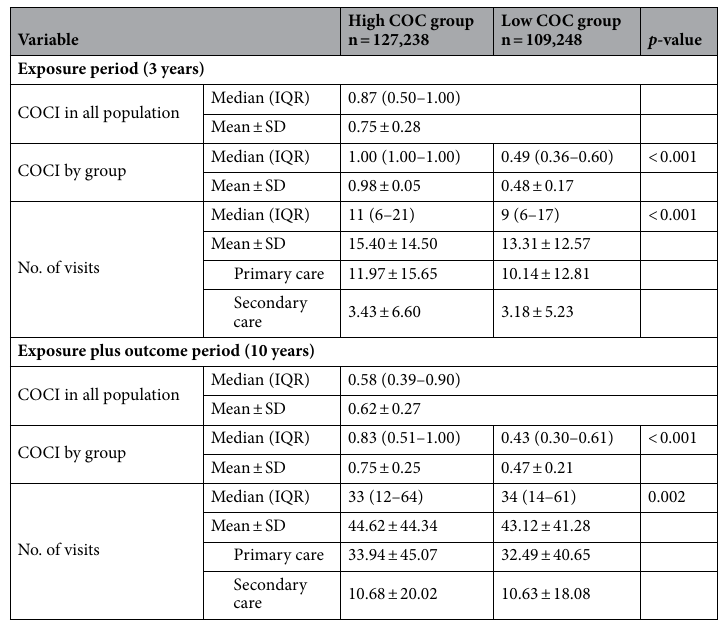
Table 2. COCI and number of visits to medical facilities by period. COC continuity of care, COCI continuity of care index, IQR interquartile range, SD standard deviation. P -values were calculated by Kruskal–Wallis tests for continuous variables.